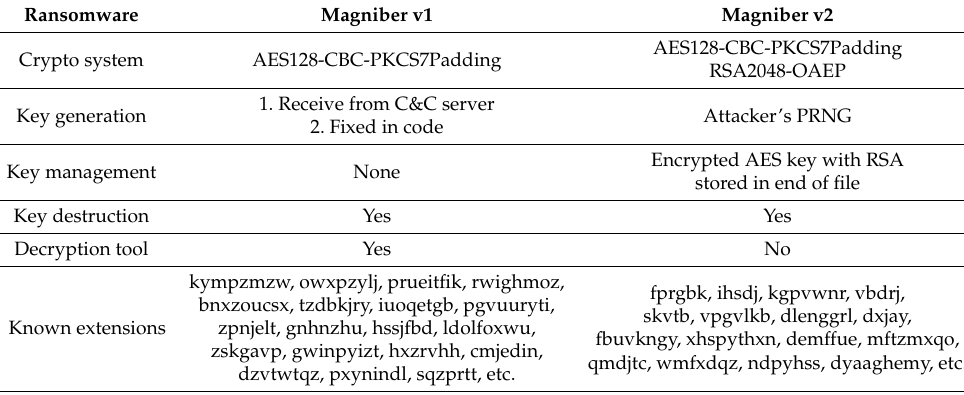
Table 1. Comparison of Magniber version 1 and